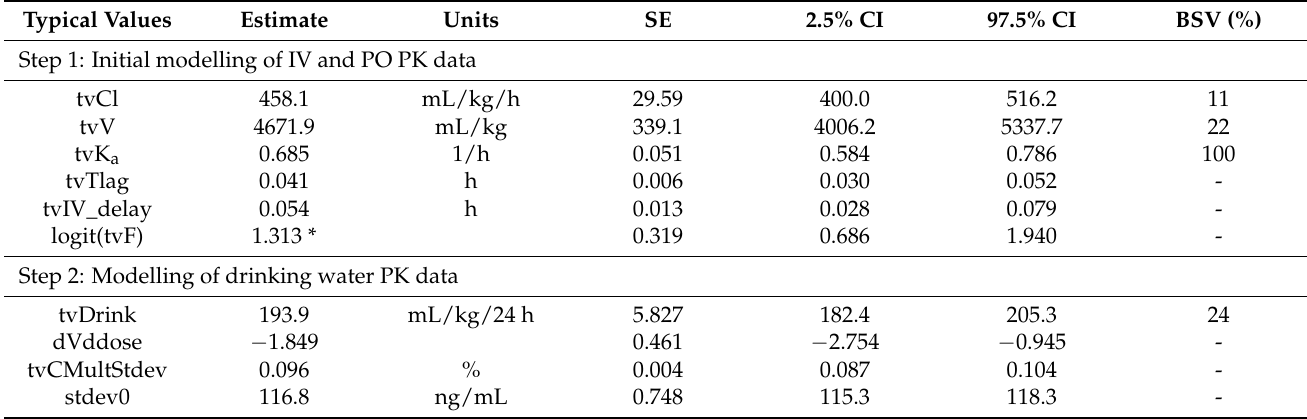
Table 1. Population primary (thetas) parameters of enrofloxacin in broilers obtained via sequential modelling and their associated standard error (SE), the lower and upper bounds of the 95% confidence interval (CI) and the estimated between- subject variability (BSV). First, the IV and PO data were fitted with a one-compartment model with IV delay and Tlag functions. Second, the drinking water PK data was added and the parameters Drink and dVddose were estimated. Typical Values Estimate Units SE BSV (%) Step 1: Initial modelling of IV and PO PK data tvCl 458.1 tvV 4671.9 mL/kg